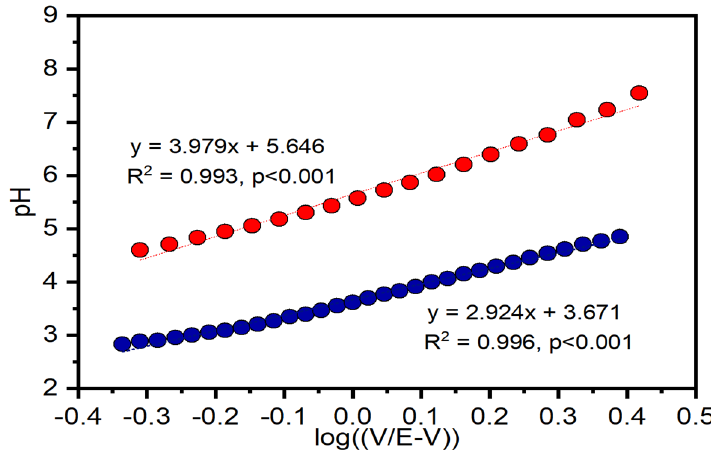
Figure 6. Henderson–Hasselbalch plots of HA extracted from aerobically (HA ox , blue circles) and anaerobically (HA red , red circles) incubated peat.